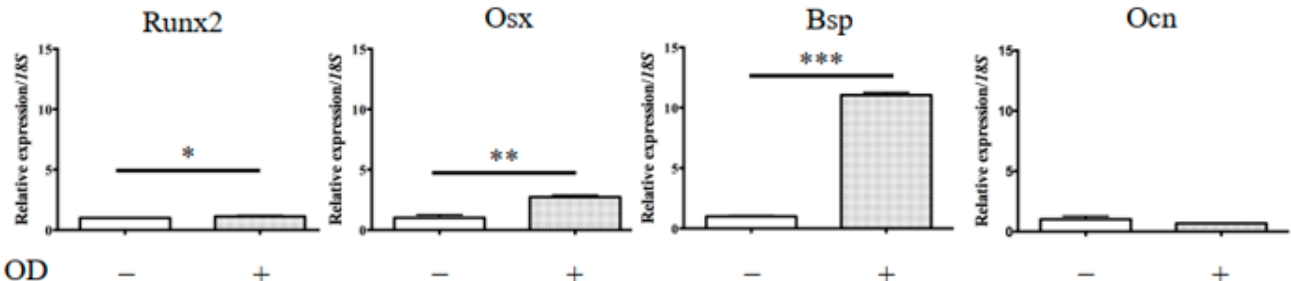
Figure 4. mRNA expression of osteogenesis-related genes in KUSA-A1 cells on a plastic plate. After 7 days of culture, the mRNA expression of the BSP gene in a 2D+ environment was markedly increased compared with that in a 2D environment. The data represent the mean ± SD of four independent experiments. Each experiment was performed in triplicate; * p < 0.05, ** p < 0.01, and *** p < 0.001. 2D: KUSA-A1 cells were cultured without osteogenic differentiation medium on a plastic plate; 2D+: KUSA-A1 cells were cultured with osteogenic differentiation medium on a plastic plate; Runx2: Runt-related transcription factor 2, Osx: osterix, Bsp: bone sialoprotein, Ocn: osteocalcin.